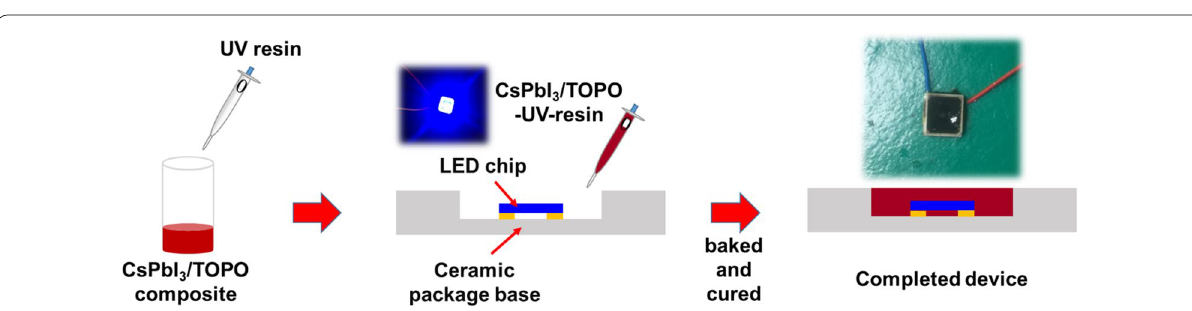
Fig. 2 Schematic representation of encapsulating